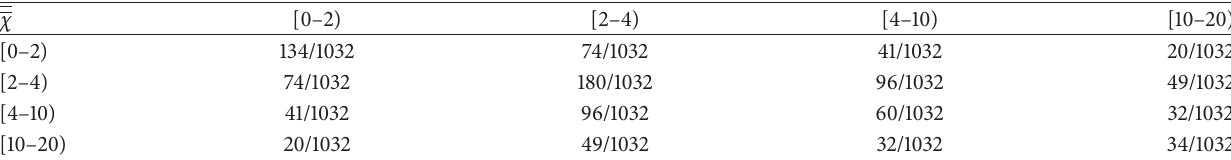
Table 9: DegreeBinned bivariate 𝜒